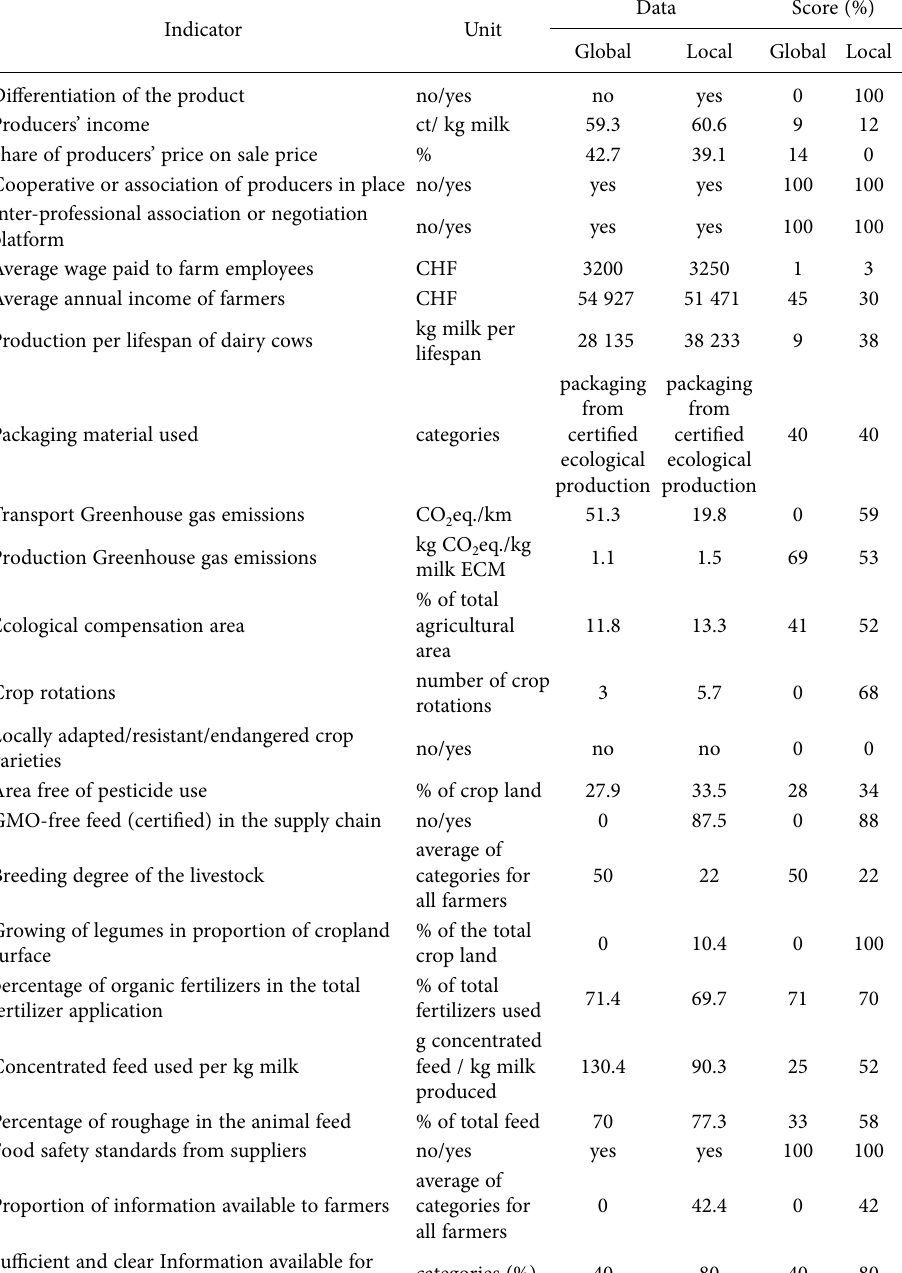
Table 4. Data for indicators and performance